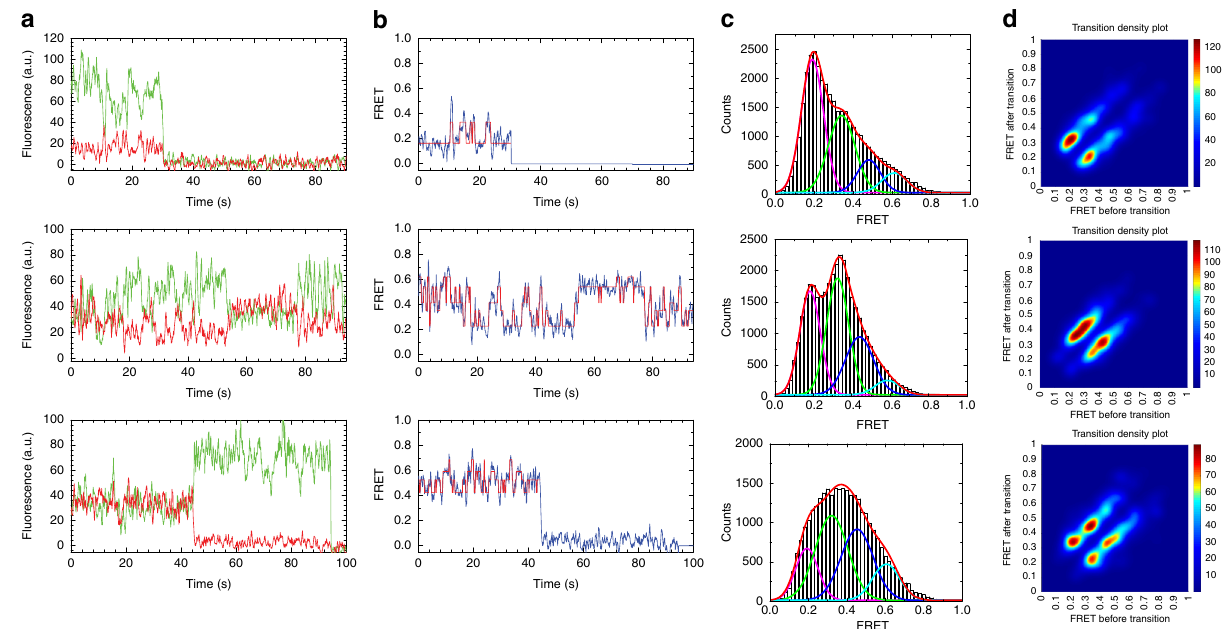
Fig. 4 Dynamics in the apo and substrate bound CmeB pump. a Experimental trace of CmeB single-molecule dynamics with donor ( green ) and acceptor ( red ) fl uorescence (in the absence of Tdc, top panel ; in the presence of 1 μ M Tdc, middle panel ; in the presence of 10 μ M Tdc, bottom panel ). b FRET trajectories ( blue ) and idealization of these FRET ef fi ciencies ( red ) (in the absence of Tdc, top panel ; in the presence of 1 μ M Tdc, middle panel ; in the presence of 10 μ M Tdc, bottom panel ). c FRET ef fi ciency population histograms of CmeB (in the absence of Tdc ( n = 69 traces), top panel ; in the presence of 1 μ M Tdc ( n = 77 traces), middle panel ; in the presence of 10 μ M Tdc ( n = 73 traces), bottom panel ). The histograms were fi tted with Gaussian functions. d Transition density plots for the CmeB ef fl ux pump (in the absence of Tdc, top panel ; in the presence of 1 μ M Tdc, middle panel ; in the presence of 10 μ M Tdc, bottom panel